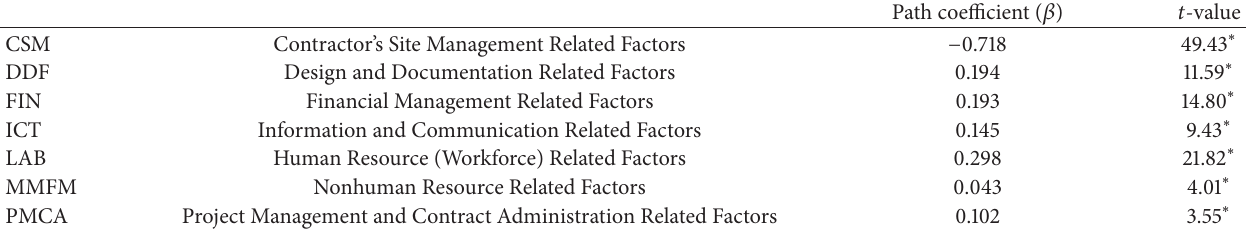
Table 4: Path coefficient with 𝑡 -values for the structural